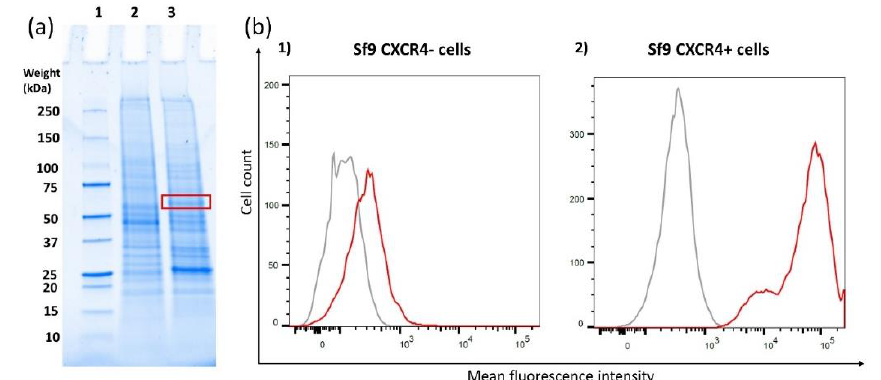
Figure 1. ( a ) SDS-PAGE of the membrane fractions of sf9-negative control cells ( a , 2 ) and sf9 cells overexpressing CXCR4 ( a , 3 ) including a control sample ( a , 1 ) indicating weight points. The red square indicates the band of CXCR4 which is only present in line 3. ( b ) Flow cytometry results depicting the binding of mAb 12G5 on sf9 cells in order to verify CXCR4 overexpression on the cell membrane. The left graph depicts the results from CXCR4-negative cells, which were not transfected with the CXCR4 plasmid ( b , 1 ). The right depicts the results the sf9 cells that were transfected with the CXCR4 plasmid ( b , 2 ). Cells stained with an isotype control Ab (IgG2a) (grey) were included as control, and cells stained with 12G5 mAb are shown as the red